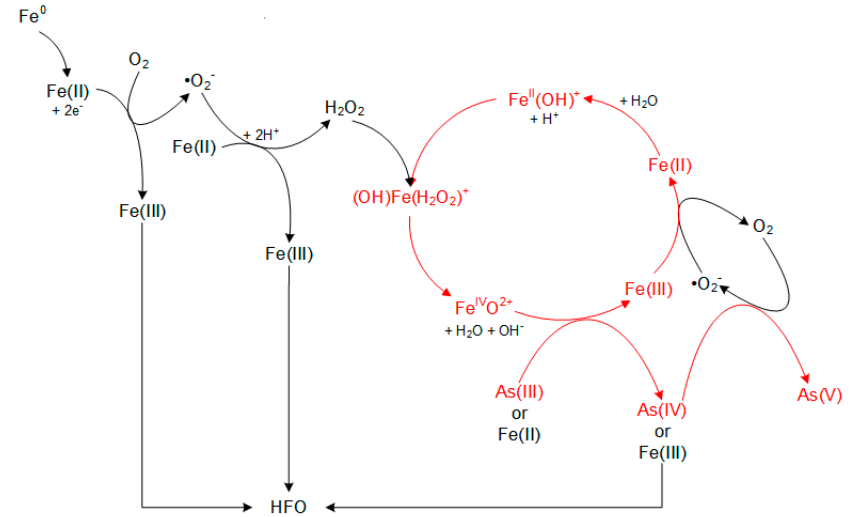
Figure 5. As(III) oxidation mechanism in advanced EC processes [45,46]. Highlighted in red is the catalytic reaction involved in the oxidation of As(III) to As(V).